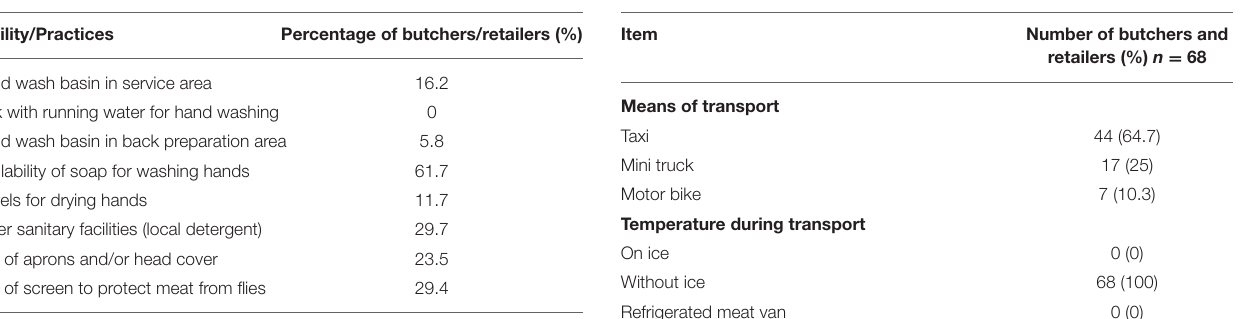
TABLE 3 | Hygienic practices of butchers/retailers in Ashaiman municipality. TABLE 4 | Transportation of beef to retail